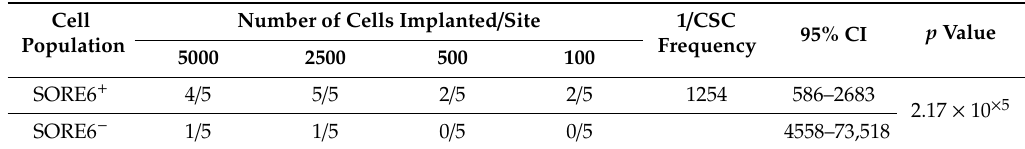
Table 1. The frequency of tumor formation in nude mice ( n = 5) inoculated with the indicated number of SORE6 + and SORE6 − cells sorted from PC3 cells. The tumor incidence was assessed via BLI, two months after inoculation. CI, conference interval. p , p value for the di ff erence in CSC frequencies between the SORE6 + and SORE6 − cells.